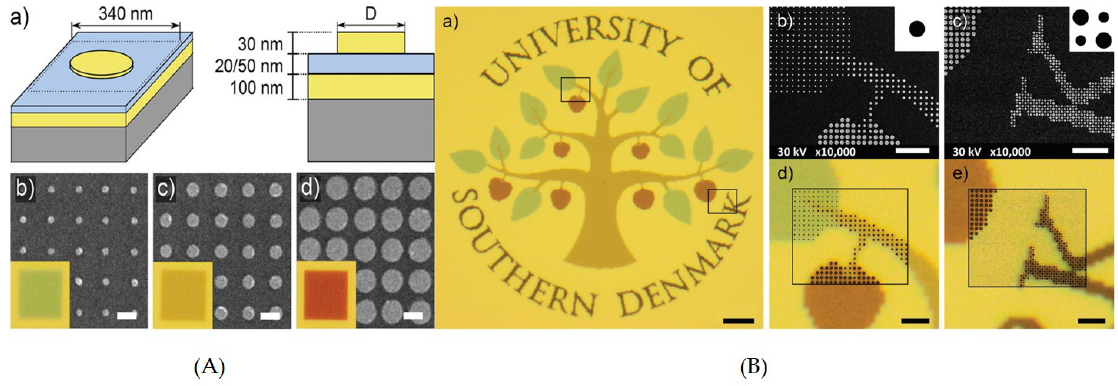
Figure 7. ( A ) Schematic diagram of a circular gap plasmonic nano microscopic images of the highly uniformed colors due to an array ( B ) Precise color printing on an optical microscopic image demonstrate bright colors with high contrast, and demonstrate that even single pixel details are colored and discernible. Reproduced with permission of [194]. Copyright American Chemical Society,